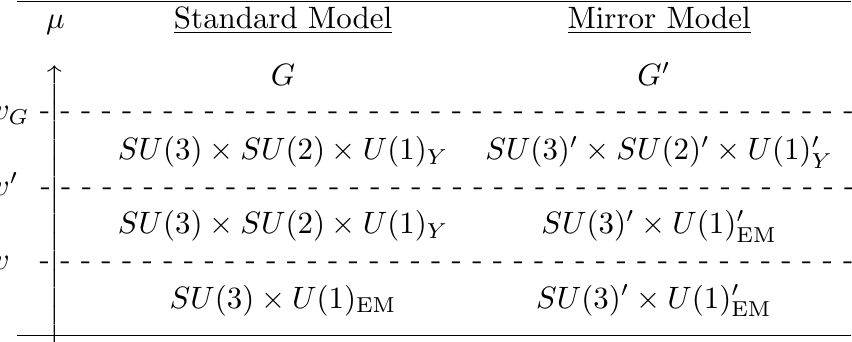
Figure 4 . Qualitative picture of the e(cid:11)ective (cid:12)eld theory at scales v; v G and G 0 do not contain any abelian factors so that kinetic mixing can only be radiatively generated at the scale v G and below, or be induced by higher dimensional operators at v G